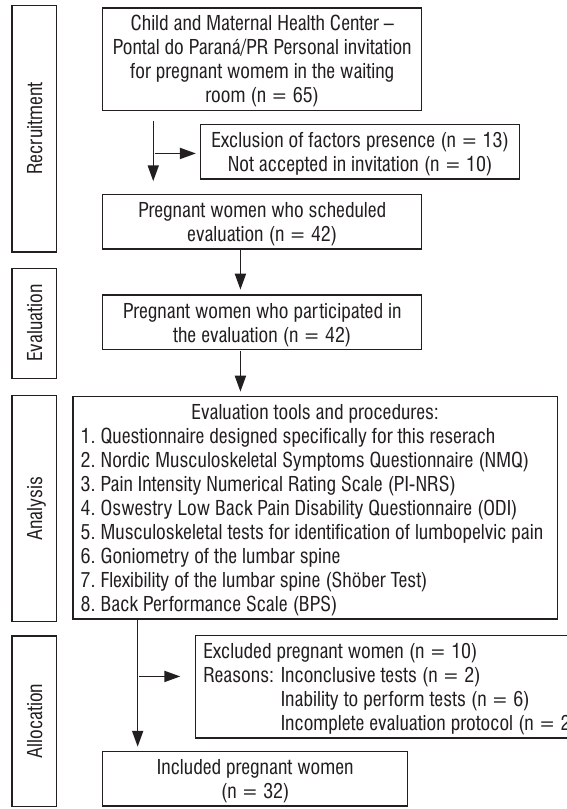
Figure 1 - Experimental design with flow diagram